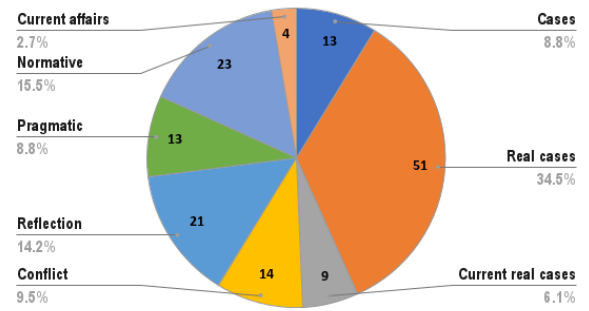
Figure 6. Didactic approach preferred by respondents.